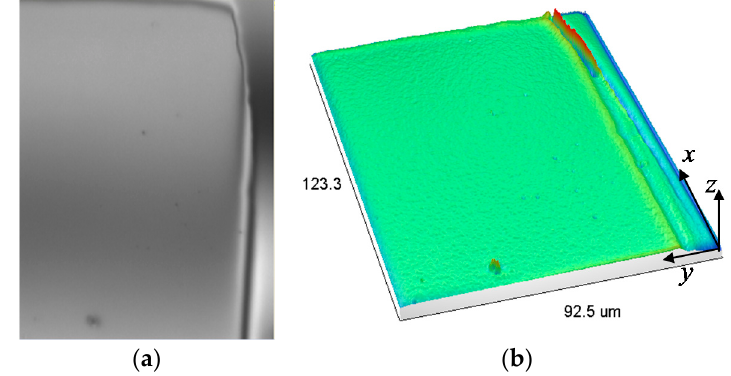
Figure 8. Gold coated electrical-pad of a MEMS silicon micro-surface: ( a ) 50X optical image; ( b ) Triangulation of a measured micro-surface area of 92.5 µm × 123.3 µm.